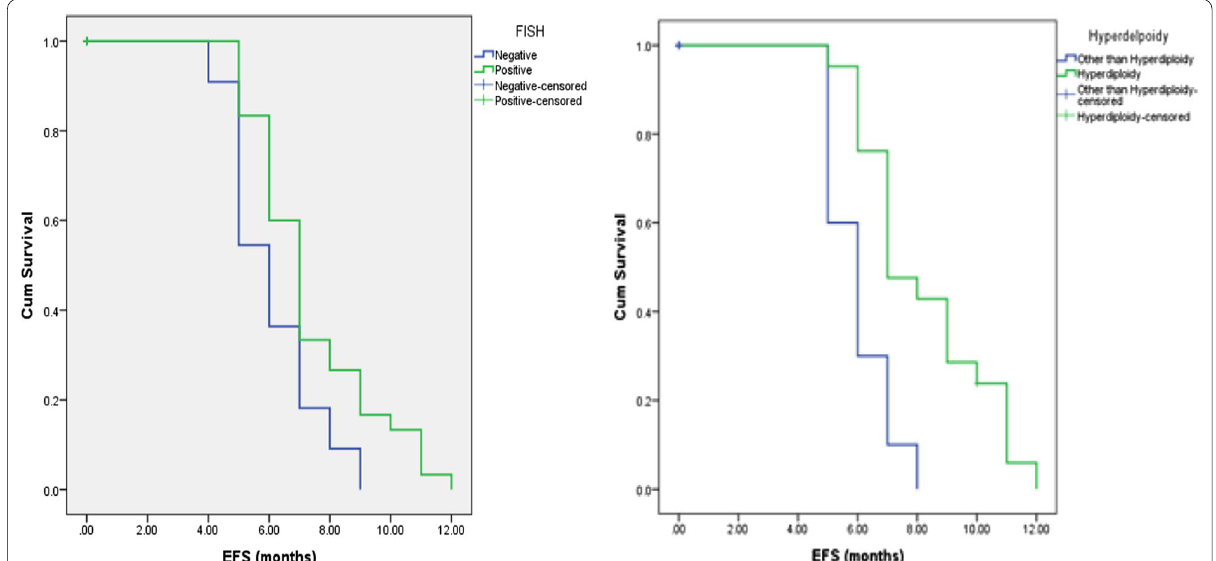
Fig. 5 Kaplan–Meier analysis for the relation between FISH results (left) and hyperdiploidy (right) and event free survival among the studied